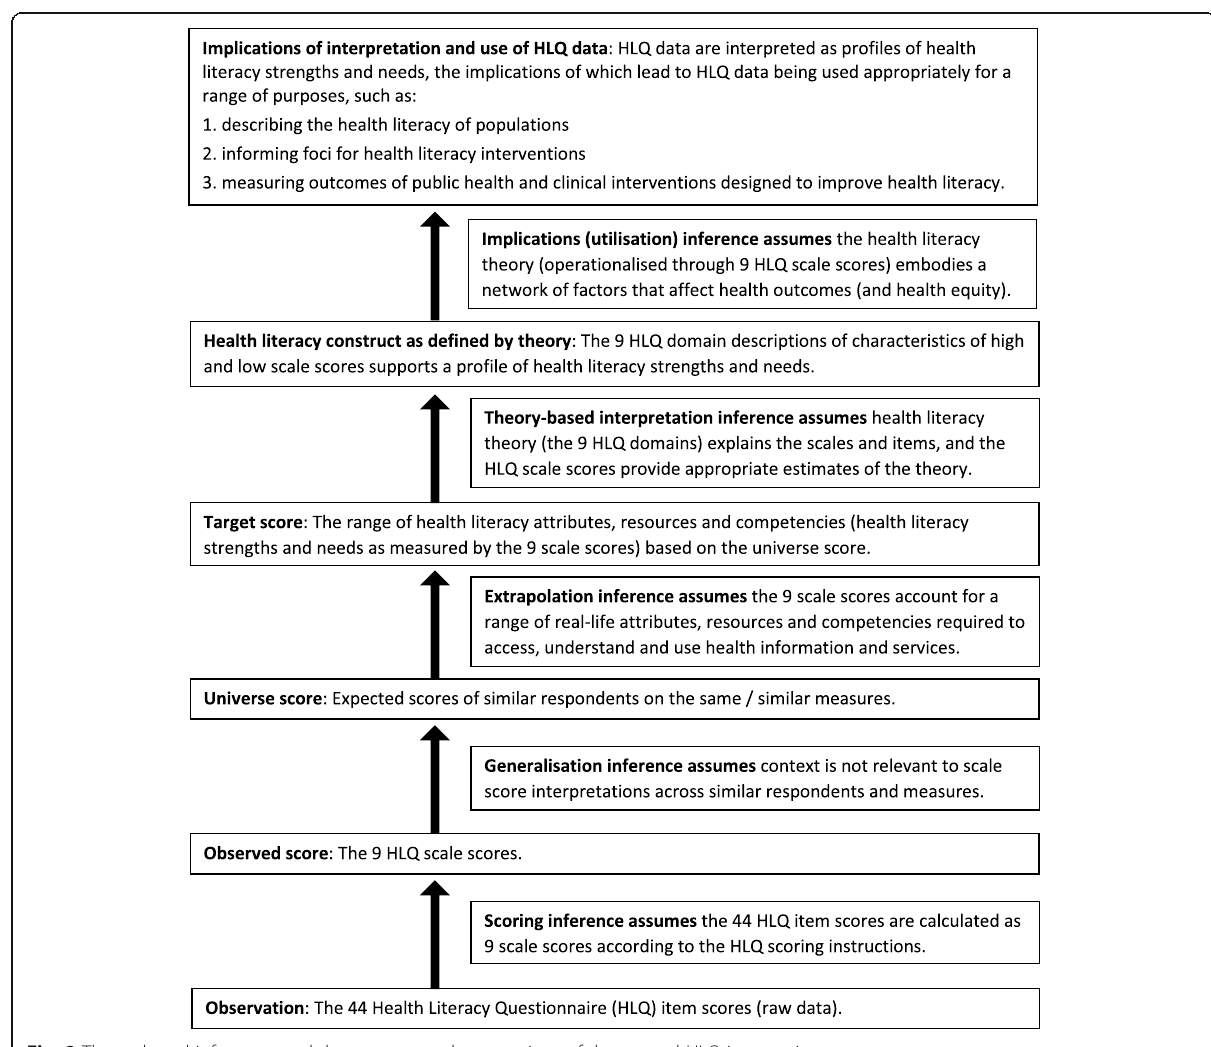
Fig. 2 Theory-based inferences and the warrants and assumptions of the general HLQ interpretive